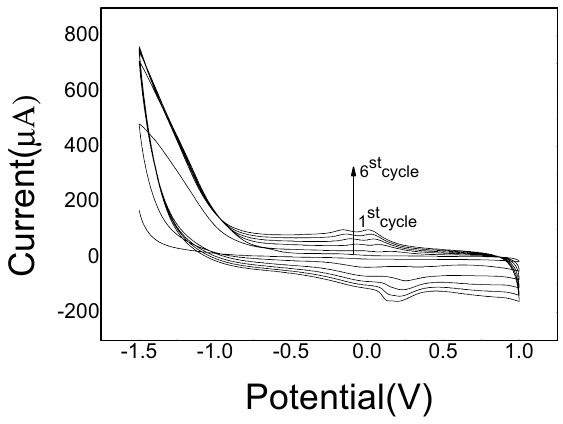
Figure 2. CV curves of electrodeposited ERGO on GCE.